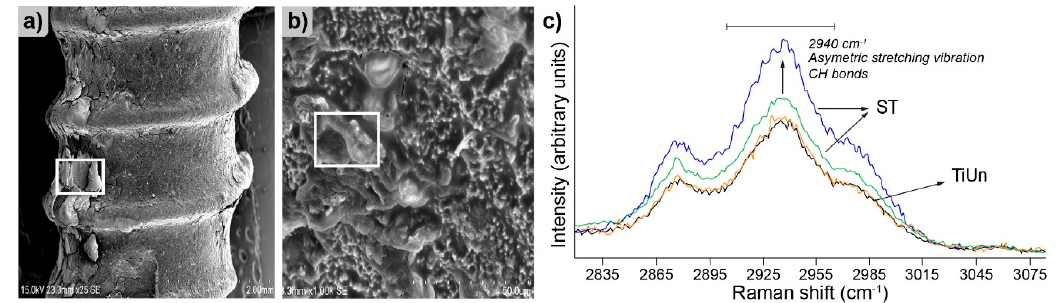
Figure 9. Scanning electron microscopy (SEM) images: ( a ) Representing the bone ‐ like augments on the Straumann ST implants followed by ( b ) a higher magnification of the implant surface, the boxed regions have been subjected to Raman analysis and ( c ) Raman spectrum depicting organic matrix deposition on Straumann ST and TiUnite systems. Figure adapted with permission from